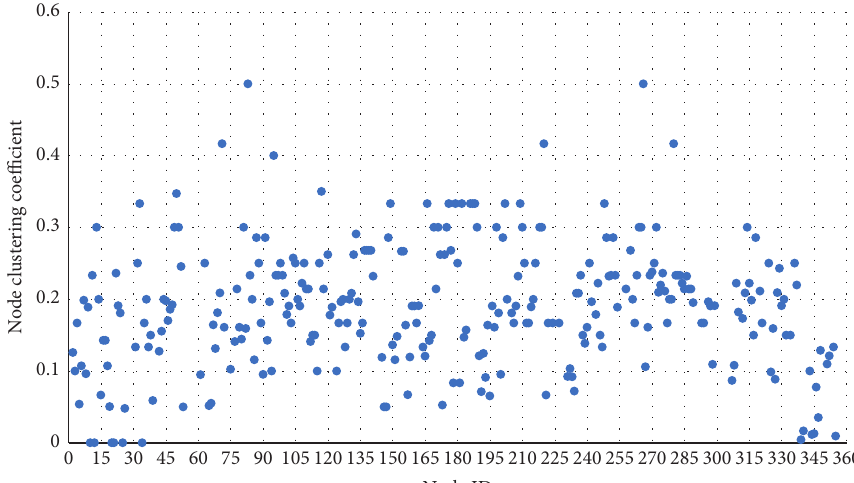
Figure 6: Clustering coefficient of nodes in PNSRTP.